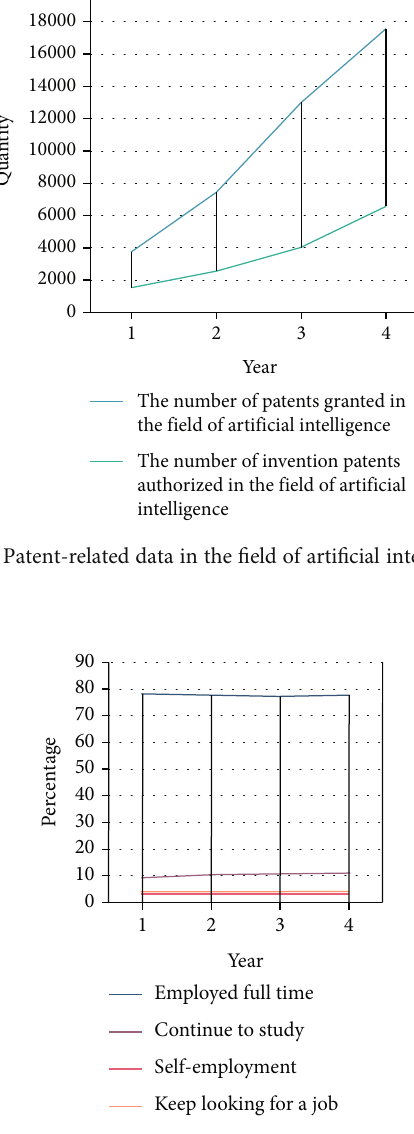
Figure 5: Graduates ’ whereabouts six months after